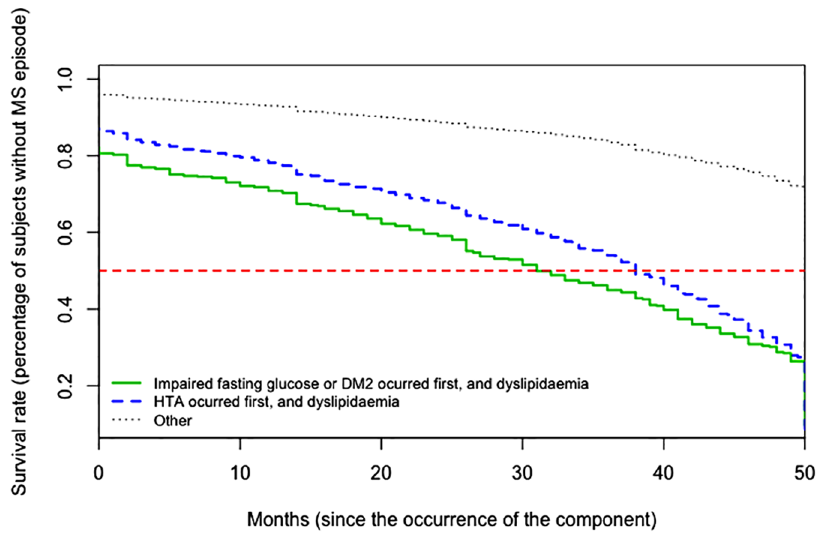
Fig 3. Survival curves. Survival rate (percentage of subjects without MS episode) from the occurrence of the component, in accordance with the first occurrence of components related to glucose metabolism, combined with dyslipidaemia. The horizontalline represents a 50% probability(of the first MS episodeoccurring).